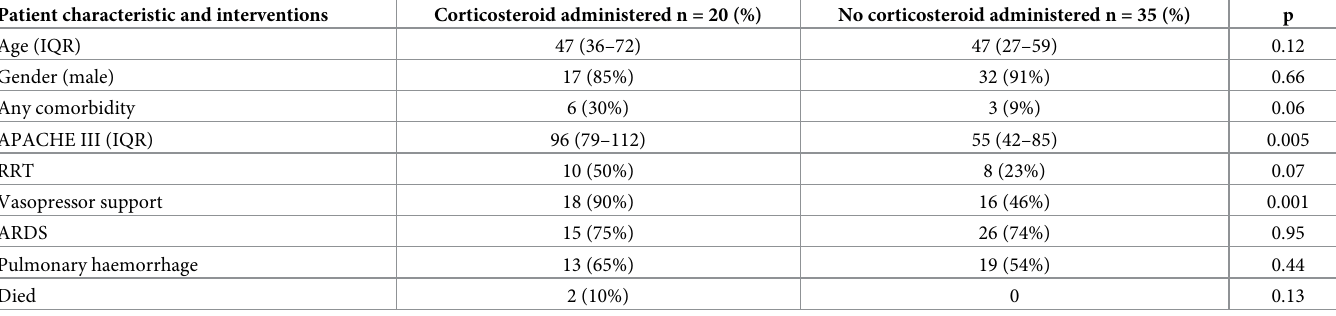
Table 7. Patient characteristic and interventions in patients with severe leptospirosis in relation to administration of corticosteroids in Far North Queensland, Aus- tralia between 1997 and 2018. Patient characteristic and